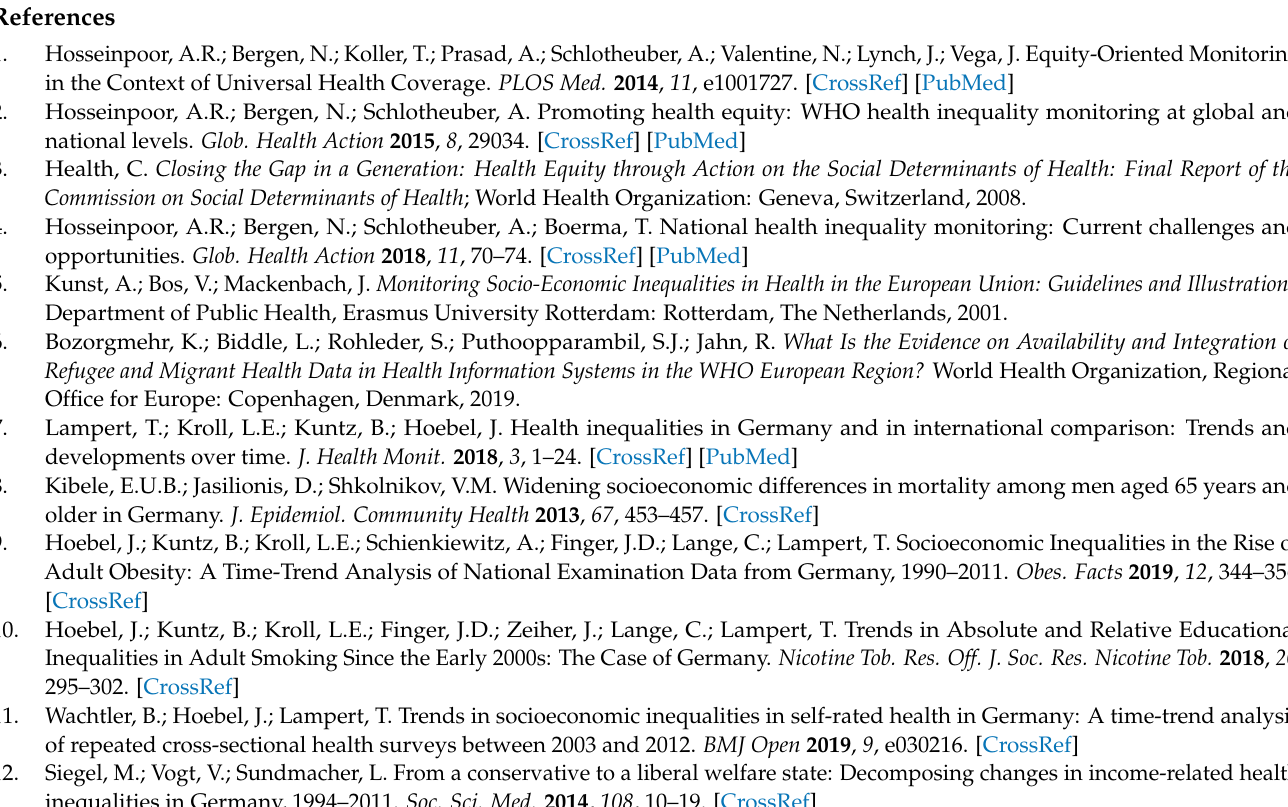
Figure S9: Absolute socio-economic inequalities in SRH in people aged 66 years and older with and without migration background, 1995–2017. Figure S10: Relative socio-economic inequalities in SRH in people aged 66 years and older with and without migration background, 1995–2017. Legend SRH: self-rated health; SII: slope index of inequality; RII: relative index of inequality; Black line: regression coefficient; Grey line: 95% confidence